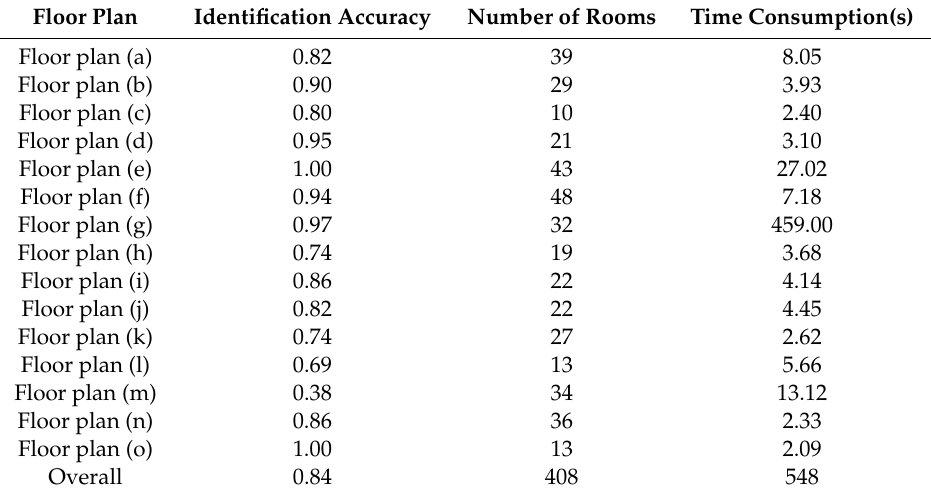
Table 2. Identification accuracy of each floor